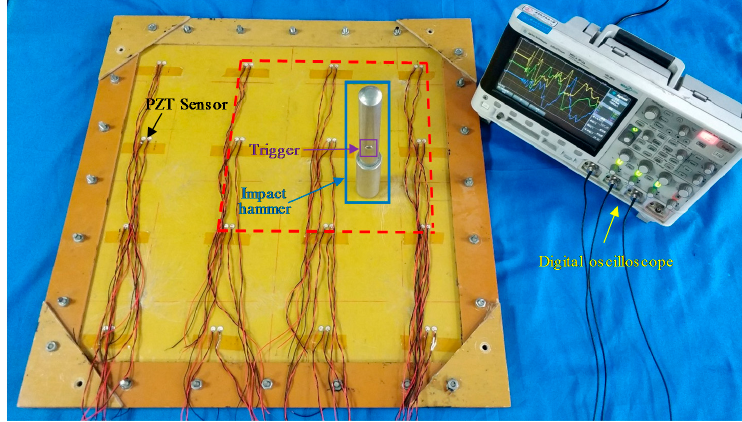
Figure 5. The experimental setup for studying the features of the continuous sensor.